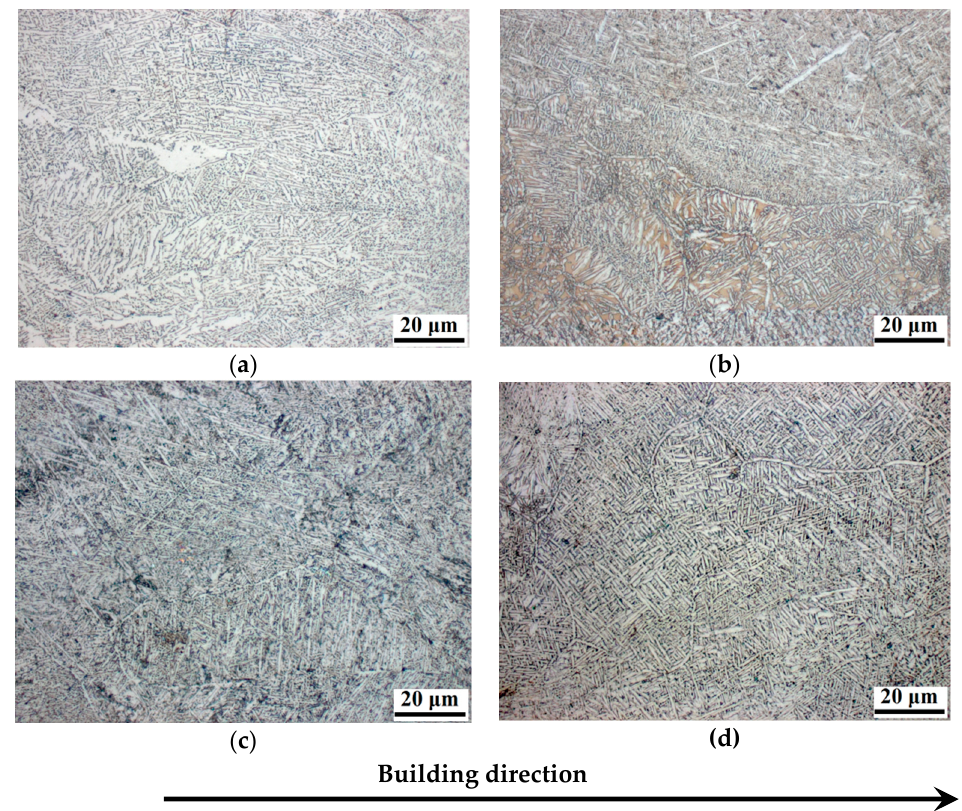
Figure 1. Optical microscopy images of microstructures of sample: ( a ) S1; ( b ) S2; ( c ) S3; ( d ) S4.